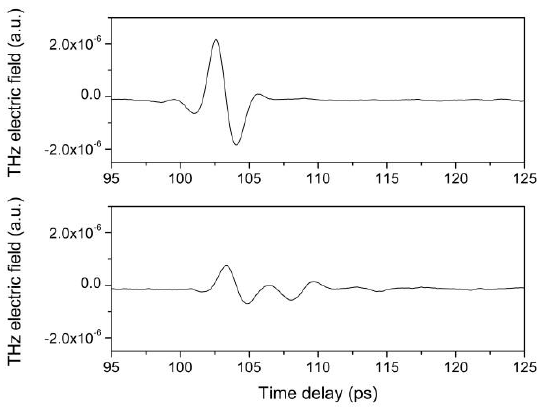
Figure 6. The upper image represents a THz pulse reflected from area D1 (metal on red bole layer) and the lower one, from area D2 (red bole on gypsum layer).